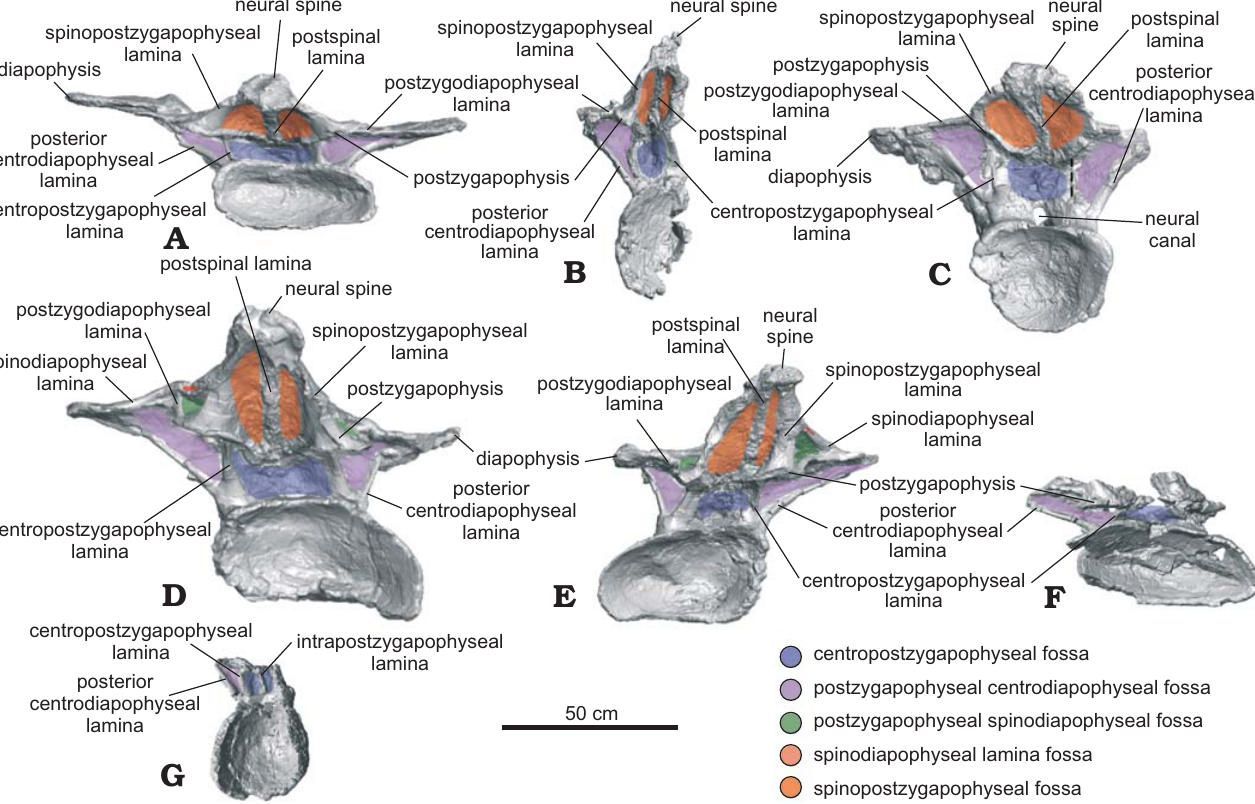
Fig. 3. Nearly complete dorsal vertebrae of titanosaurian sauropod Dreadnoughtus schrani Lacovara, Lamanna, Ibiricu, Poole, Schroeter, Ullmann, Voegele, Boles, Carter, Fowler, Egerton, Moyer, Coughenour, Schein, Harris, Martínez, and Novas, 2014, from Santa Cruz Province, Argentina; middle–late Campanian to early Maastrichtian; in posterior view. A . MPM-PV 1156?-4, estimated as the ~4 th dorsal vertebra. B . MPM-PV 1156?-5, ~5 th . C . MPM-PV 1156-6, ~6 th . D . MPM-PV 1156?-8, ~7 th . E . MPM-PV 1156?-9, ~8 th . F . MPM-PV 1156?-10, ~9 th . G . MPM-PV 1156-11, ~10 th . Dashed lines indicate frac- tured neural arch laminae. Colours indicate neural arch